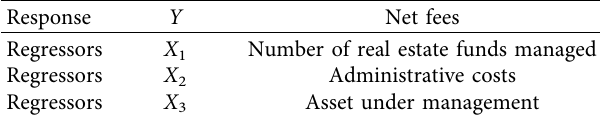
Table 3: Second multivariate